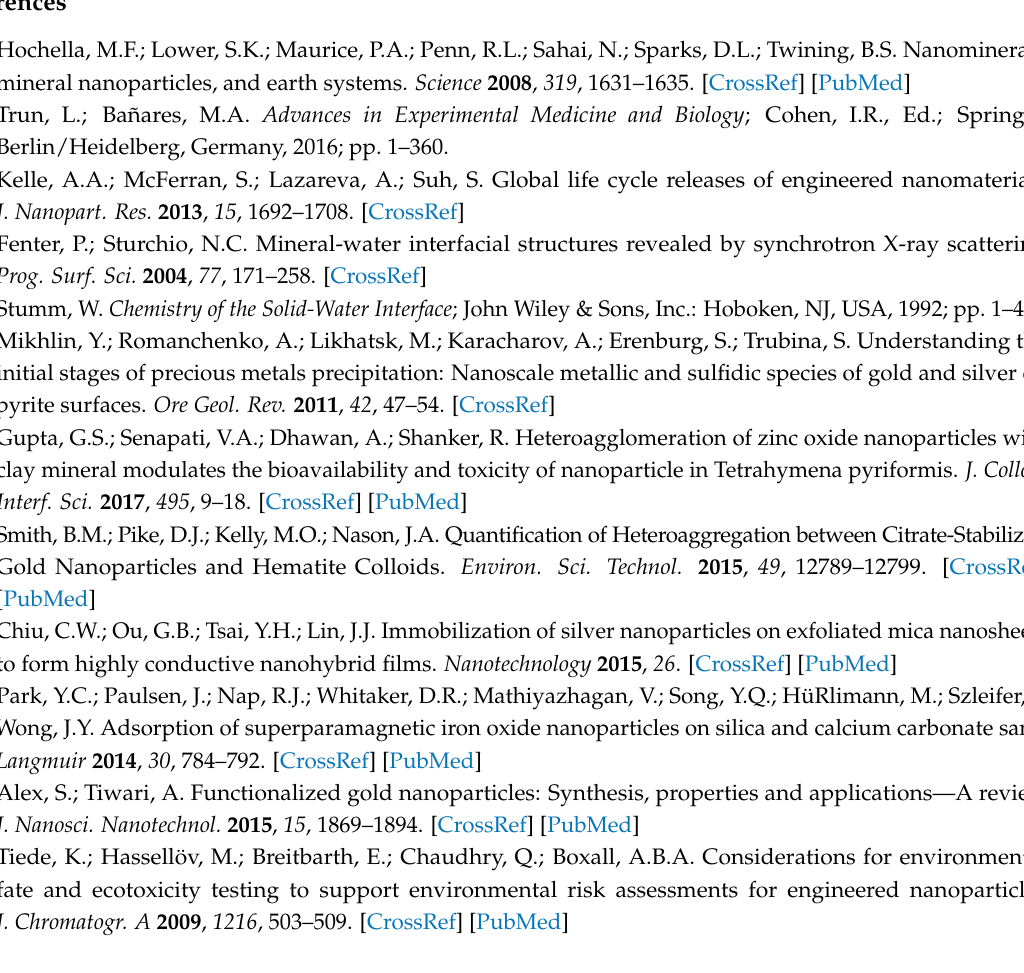
s1, Figure S1: XRD of pyrite; Figure S2: SEM micrographs of synthesized pyrite; Figure S3: Effect of ageing on the stability of positively charged AuNPs; Figure S4: Au 4f XPS spectrum of pyrite after sorption of positively charged AuNPs; Figure S5: zeta potential of pyrite at different NaCl concentrations (pH = 4); Figure S6: zeta potential of pyrite at different NaCl concentrations (pH = 7); Figure S7: zeta potential of positively charged Au NPs at different NaCl concentrations (pH = 4); Figure S8: zeta potential of positively charged Au NPs at different NaCl concentrations (pH =